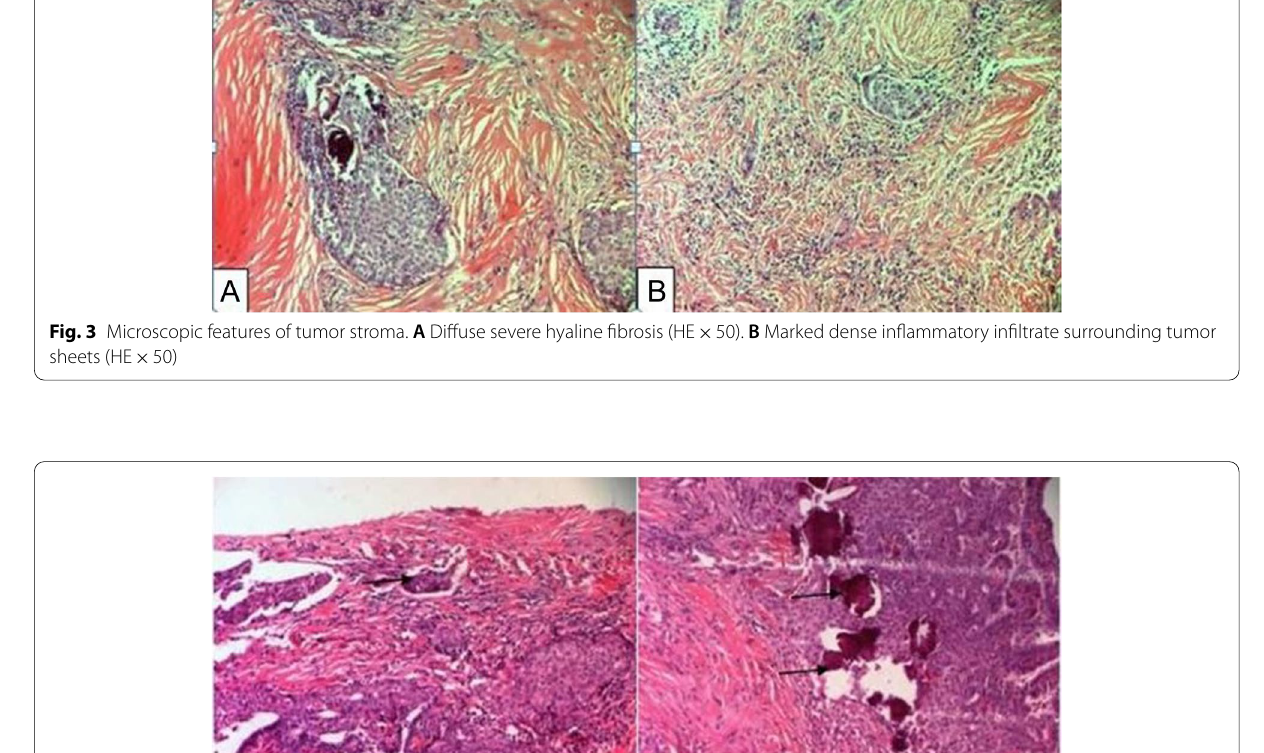
Fig. 4 Other tumor particularities. A Presence of lymphatic emboli within tumor (HE arrow) are observed (HE ×